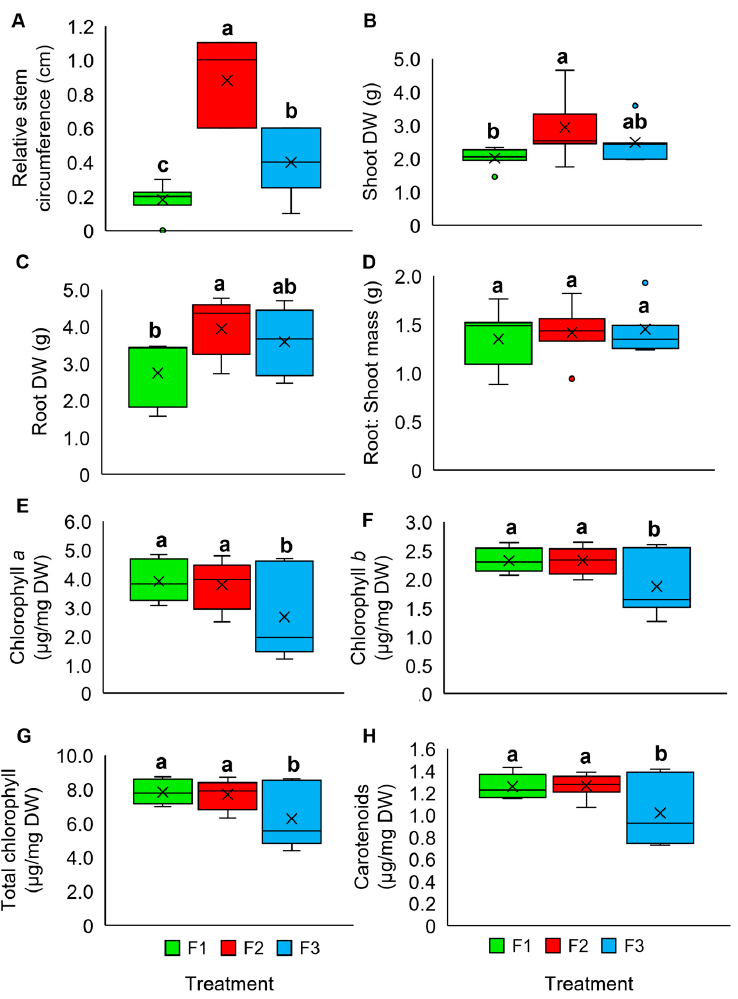
Figure 2. The plant morphological and pigment analyses of the Pandanus amaryllifolius were subjected to different application frequencies. F1: applied once at 6-day intervals, F2: applied once at 3-day intervals, and F3: applied once at 1-day intervals. ( A ) Relative stem circumference. ( B ) Shoot dry weight (DW). ( C ) Root DW. ( D ) The root-to-shoot ratio ( E ) Chlorophyll a (µg mg − 1 DW). ( F ) Chlorophyll b (µg mg − 1 DW). ( G ) Total chlorophyll (µg mg − 1 DW). ( H ) Carotenoids (µg mg − 1 DW). The letter labelled on the mean value indicates a significant level between treatments based on the one-way ANOVA, followed by the post hoc Tukey test when its p -value < 0.05. The letter ‘a’ above the bars indicates the highest value, followed by ‘ab’, ‘b’, and ‘c’. The (×) labelled in the box plot indicates the mean value of the treatment, while the (•) refers to the outlier value of the replicates.